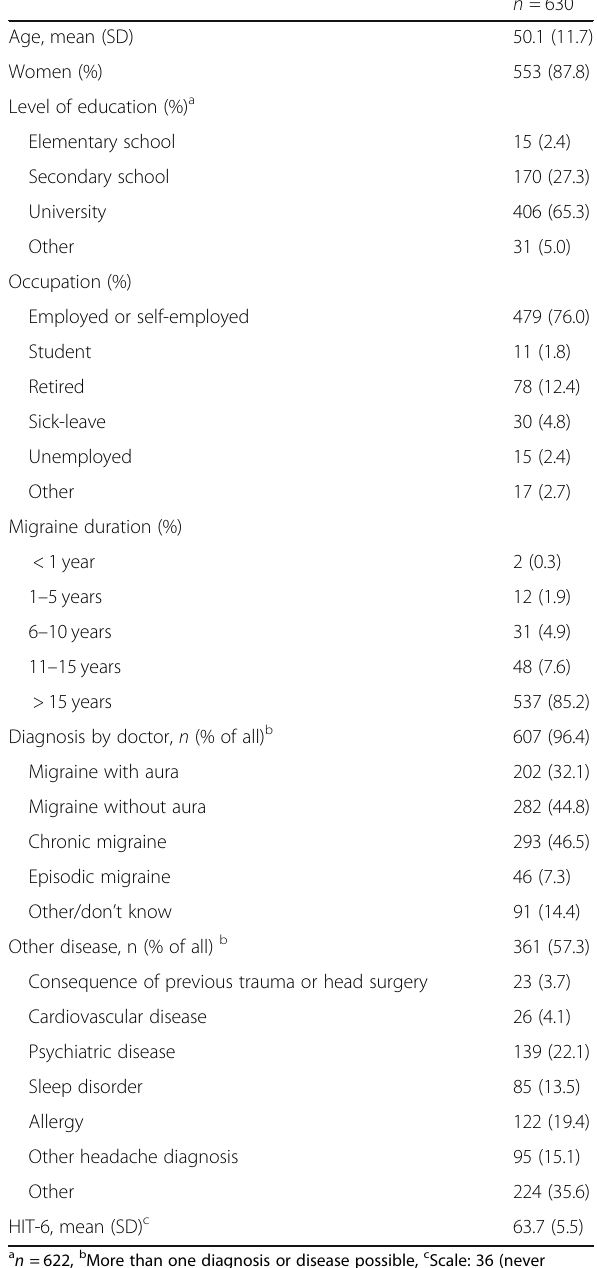
Table 1 Background